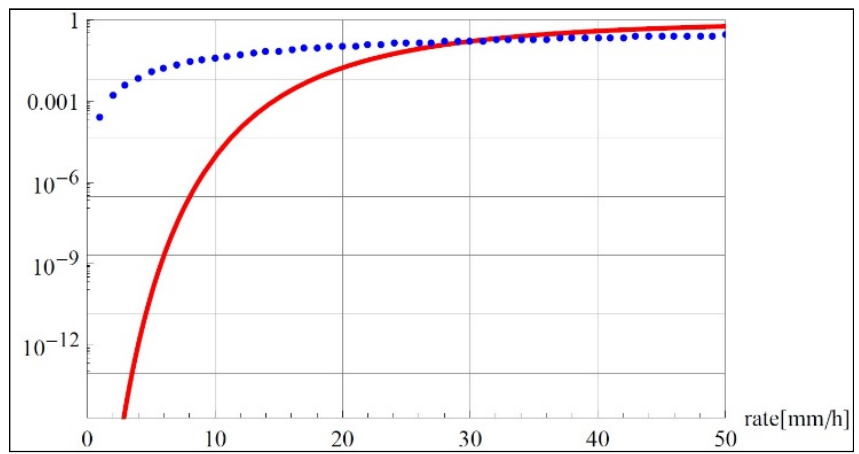
Figure 2. Logarithmic plot comparing probability for symbol error. The red solid line is the log of average probability as in (6), and the blue dotted line is the probability considering the pdf for rain, (20). For low rain rate, which would be the practical range for signal transmission, the probability for error is higher if the rain rate is considered. The calculation was performed for M = 64, f = 80 GHz.